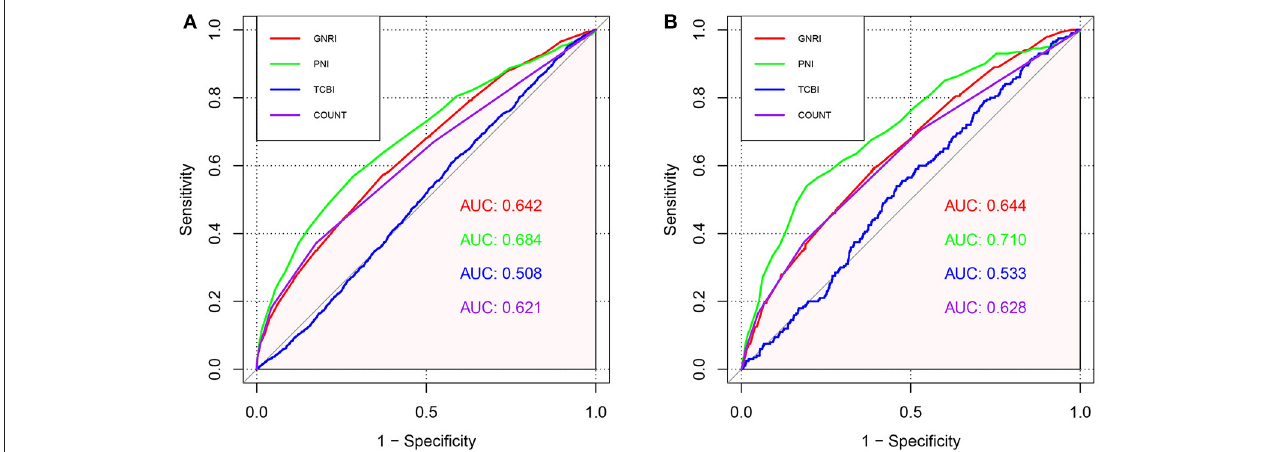
FIGURE 5 | ROC curves for predicting adverse events in the general population. (A) ROC curves for predicting all-cause mortality plotted by the nutritional scores in general population. (B) ROC curves for predicting cardiovascular mortality plotted by the nutritional scores in general population. ROC, Receiver operating characteristic; AUC, area under the curve.